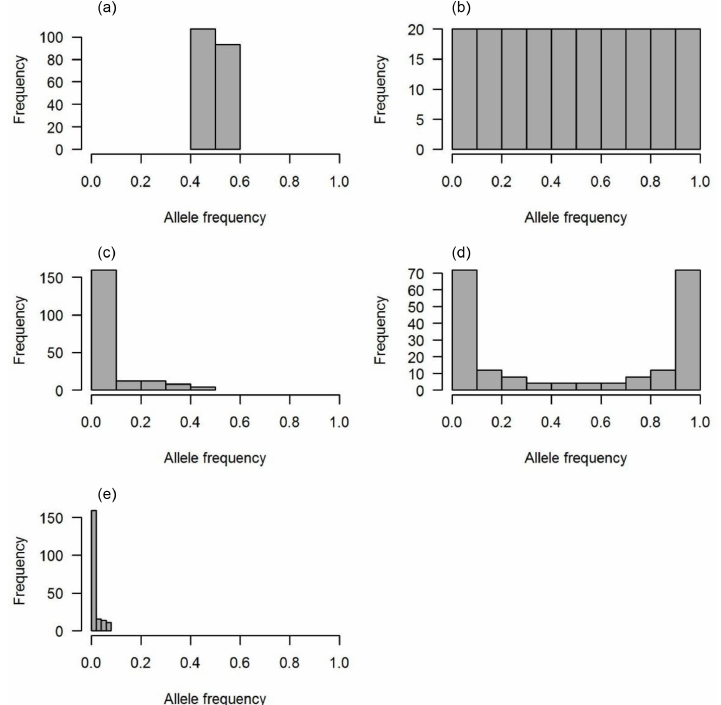
Figure 1. The distributions of QTL allele frequency. (a) Constant, (b) uniform, (c) L-shape, (d) U-shape and (e) lowMAF.